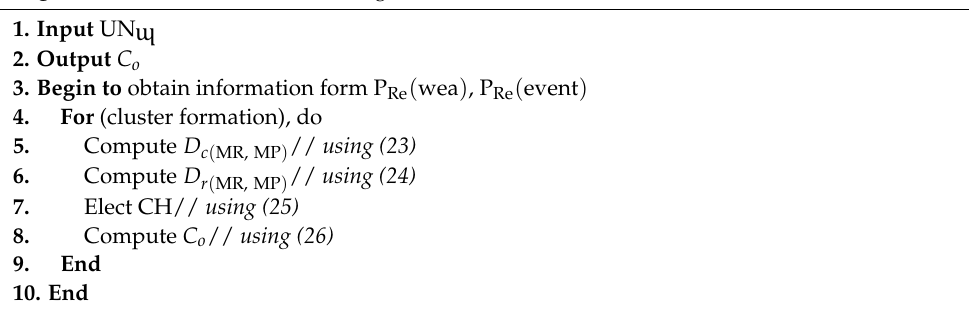
Figure 5. Density ‐ based optics clustering. Figure 5. Density-based optics clustering. Algorithm 2 Events ‐ aware Clustering. Algorithm 2 Events-aware Clustering.